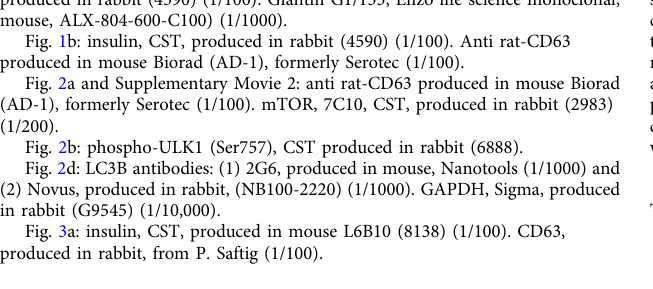
Fig. 2b: phospho-ULK1 (Ser757), CST produced in rabbit (6888). Fig. 2d: LC3B antibodies: (1) 2G6, produced in mouse, Nanotools (1/1000) and (2) Novus, produced in rabbit, (NB100-2220) (1/1000). GAPDH, Sigma, produced in rabbit (G9545) (1/10,000). Fig. 3a: insulin, CST, produced in mouse L6B10 (8138) (1/100). CD63, produced in rabbit, from P. Saftig (1/100).